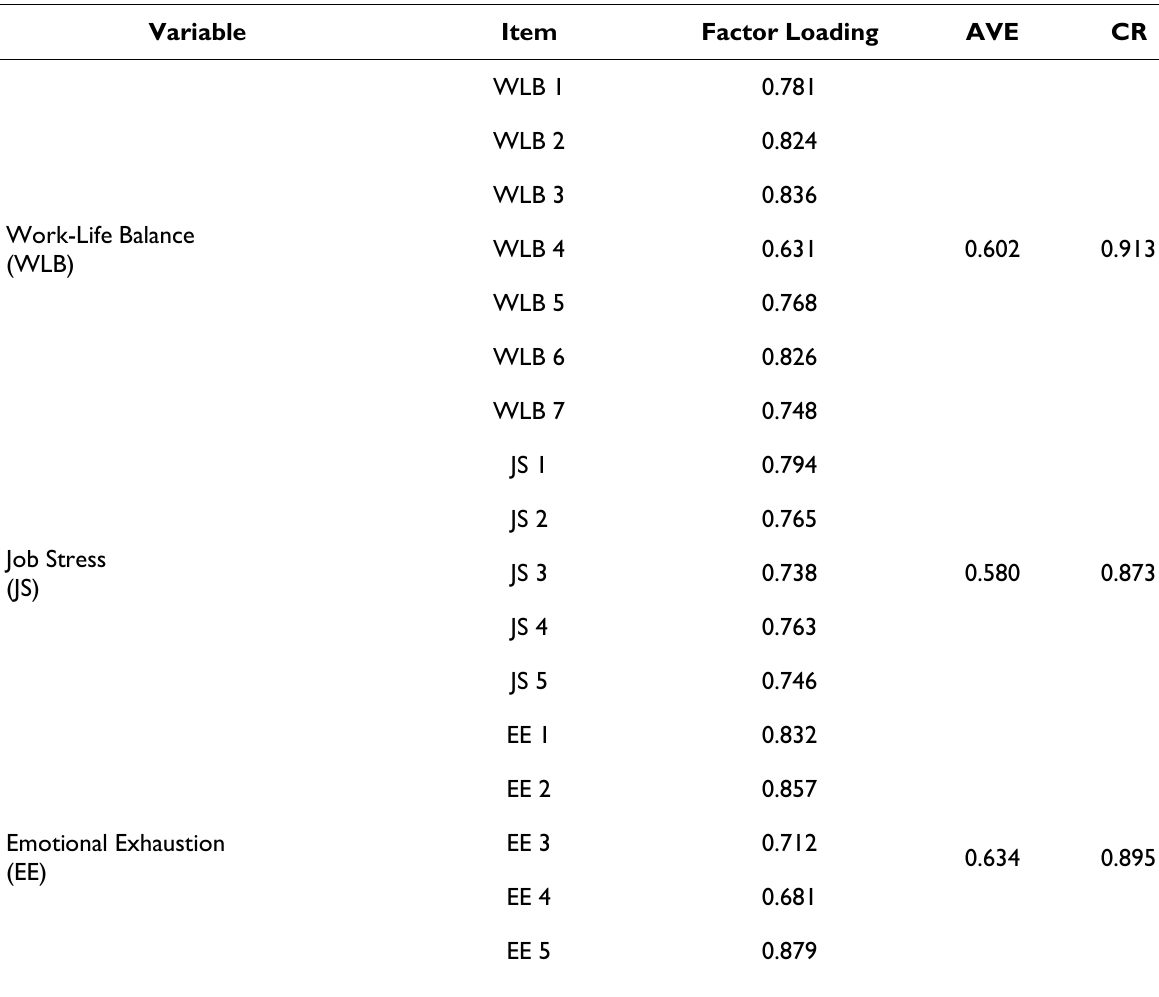
Table 2. Results of Convergent Validity and